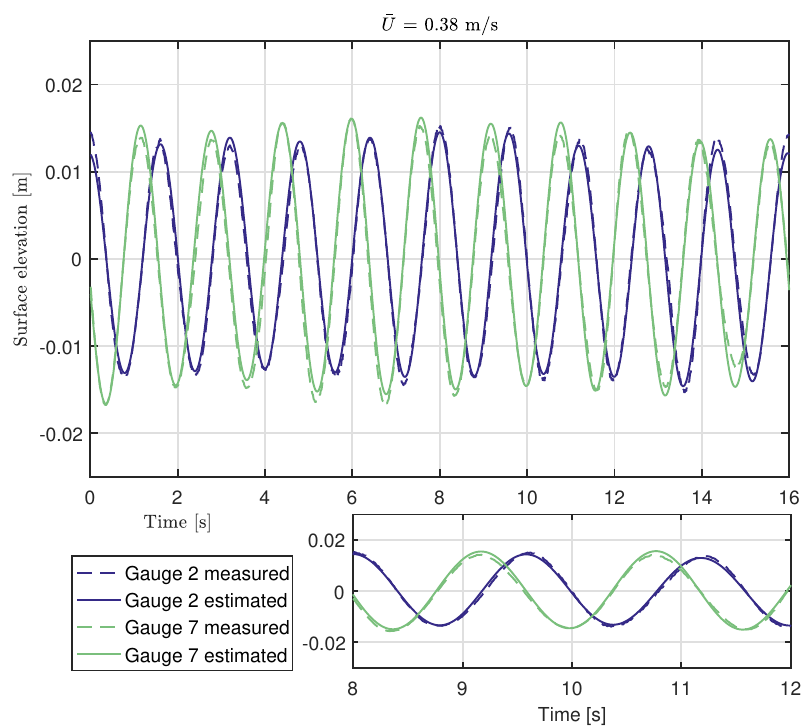
Figure 11. Example of time-series simulated from reflection analysis vs. measured over the same time period. Sea State 3 is shown with outputs for Gauges 2 and 7. The time series shown corresponds to a period of stationarity when reflections are present and does not represent the start of the test.